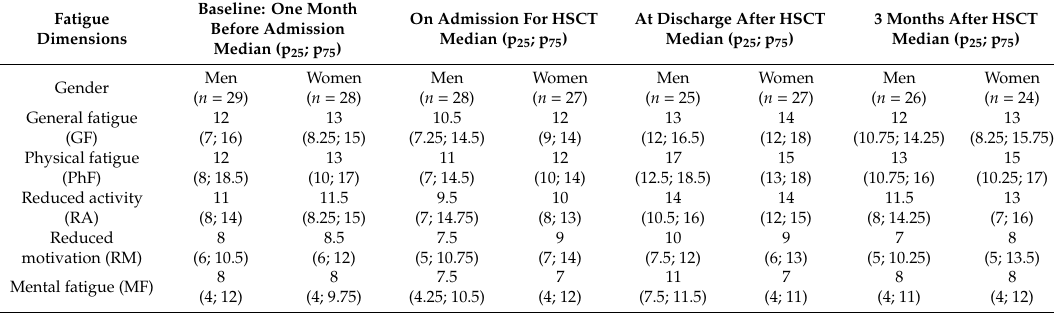
Table 2. The trajectory of fatigue levels among men and women undergoing